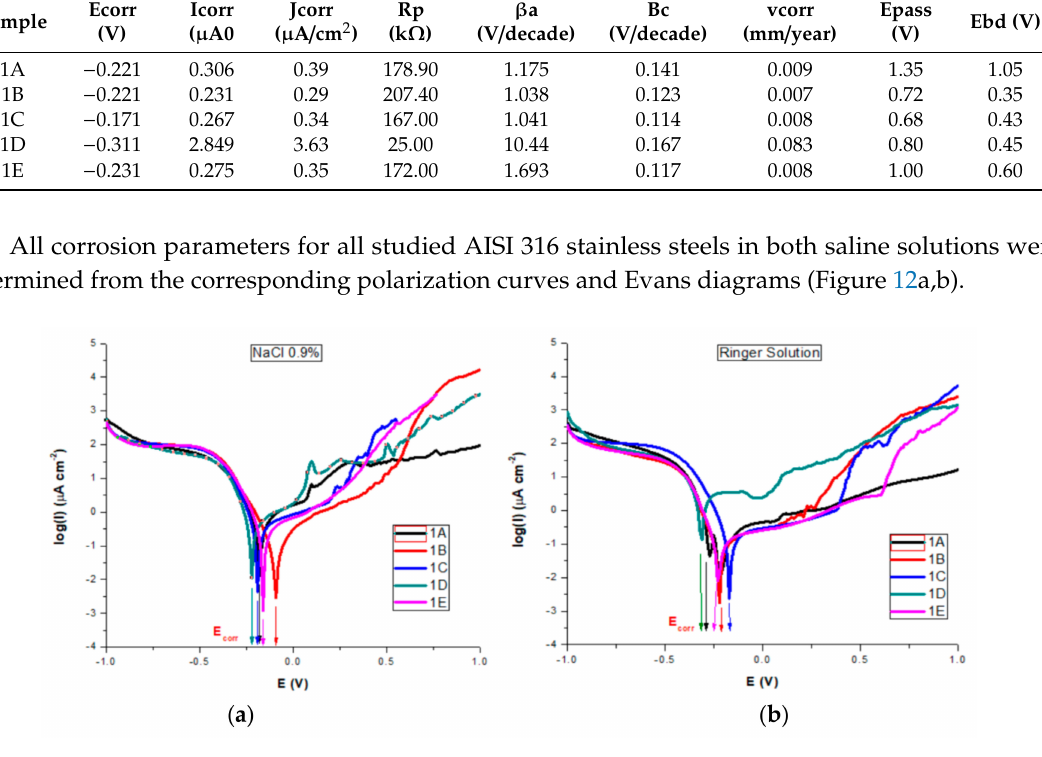
Figure 12. Evans diagrams in: (a) NaCl 0.9%; (b) Ringer’s